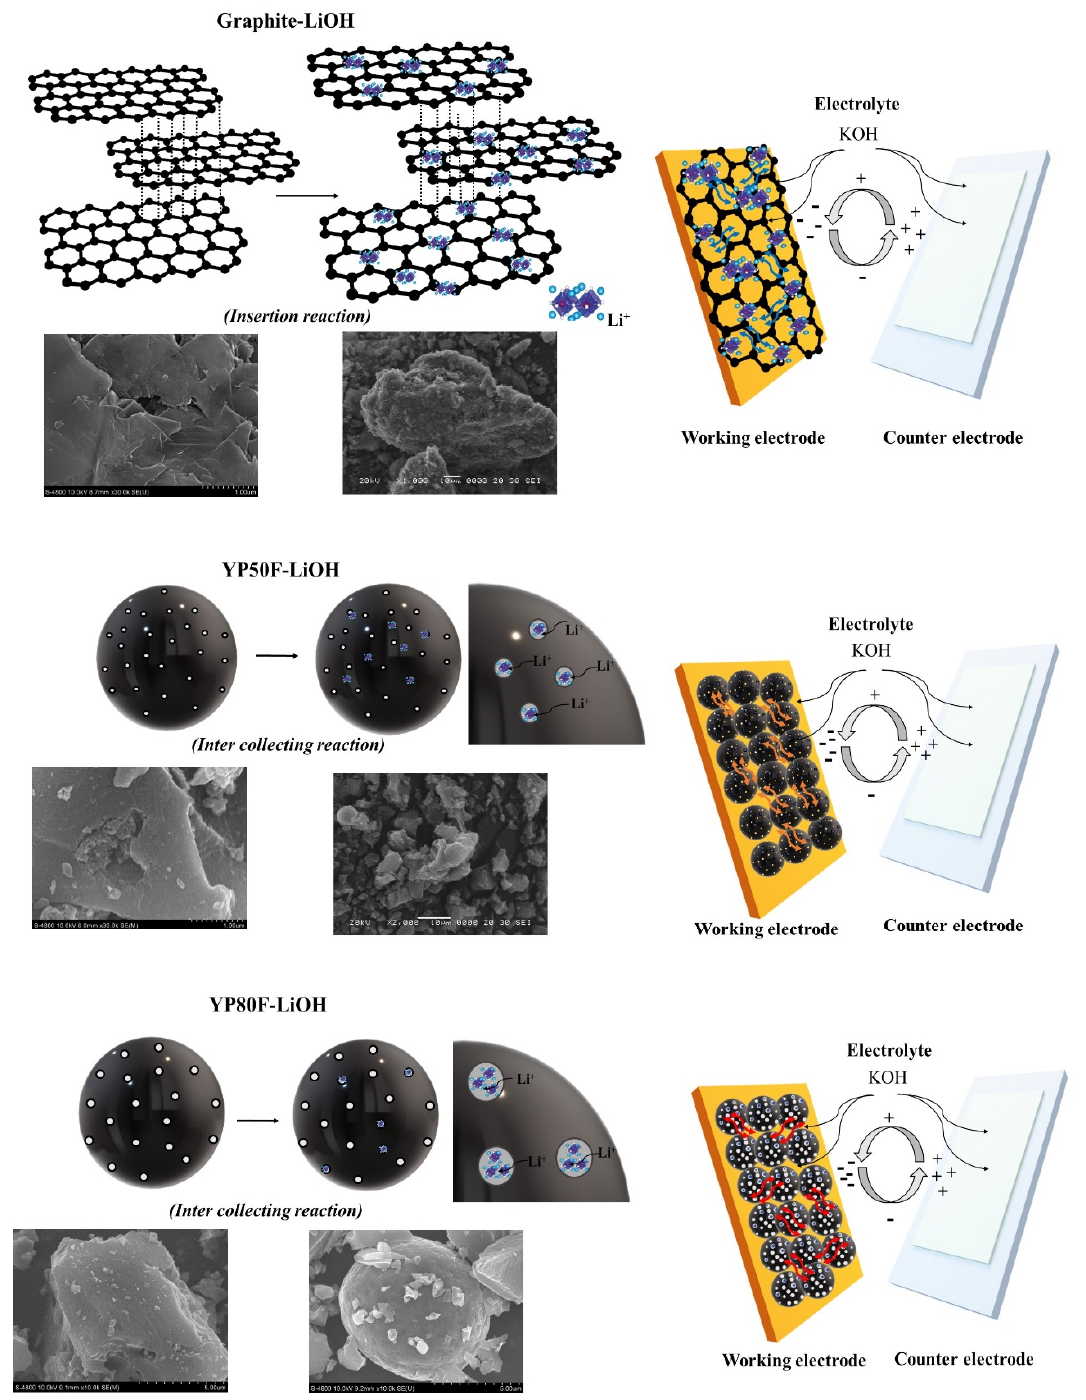
Figure 14. Schematic illustration of the preparation of LiOH-treated carbon material and electrochemical analysis.